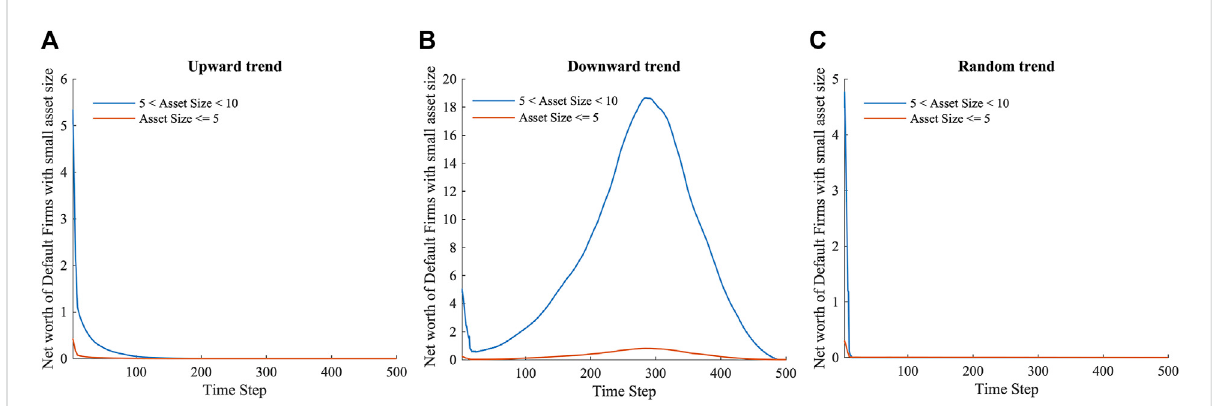
FIGURE 4 The net worth of default fi rms with small asset size and low leverage when the macroeconomic fl uctuations in upward (A) , downward (B) and random (C) trends,